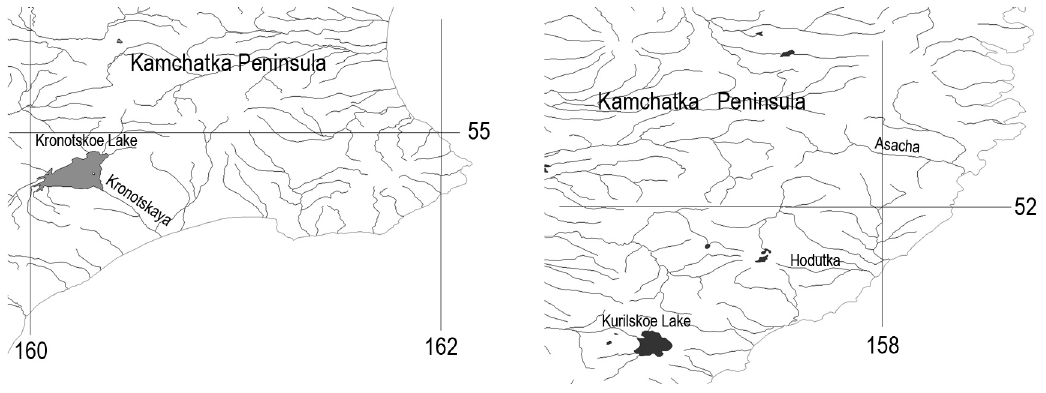
Fig. 22. Map of Sea Shore Tundra near Kronotskaya River calving grounds.